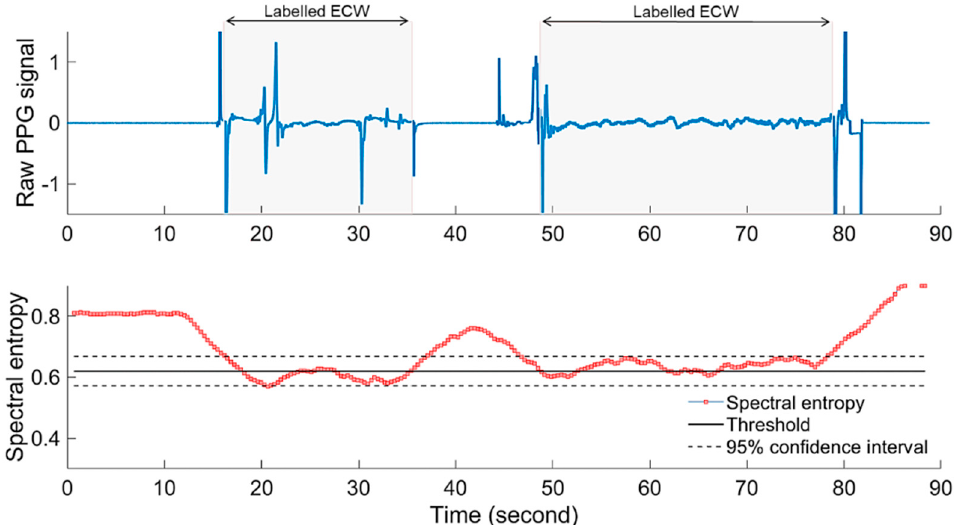
Figure 10. Raw PPG signal (upper graph) showing signal regions including cardiac waves (shaded regions) and regions with no cardiac waves. Additionally, the corresponding calculated spectral entropy, E S , (lower graph) of the raw PPG signal shows the defined E S thresholds for the cardiac signal.